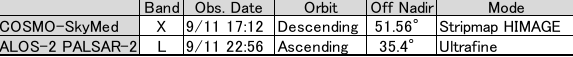
Table 3. Data specifications or SAR satellites used to estimate the extent of the inundation after the breach of the levee Band Obs. Date